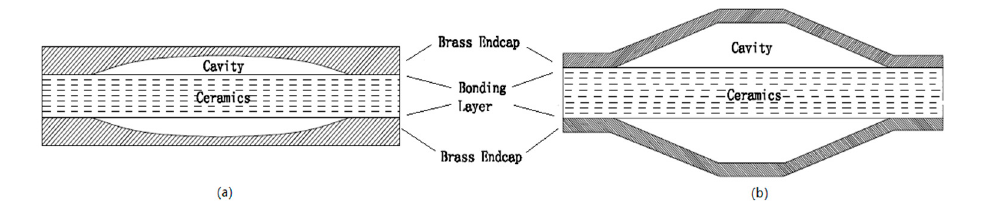
Figure 1. Moonie ( a ) and Cymbal ( b ) [15].